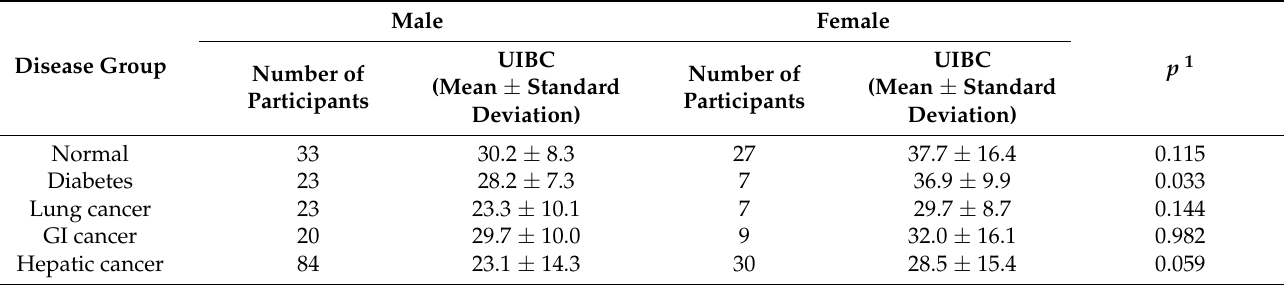
Table 2. Comparisons of UIBC between males and females in each disease group.